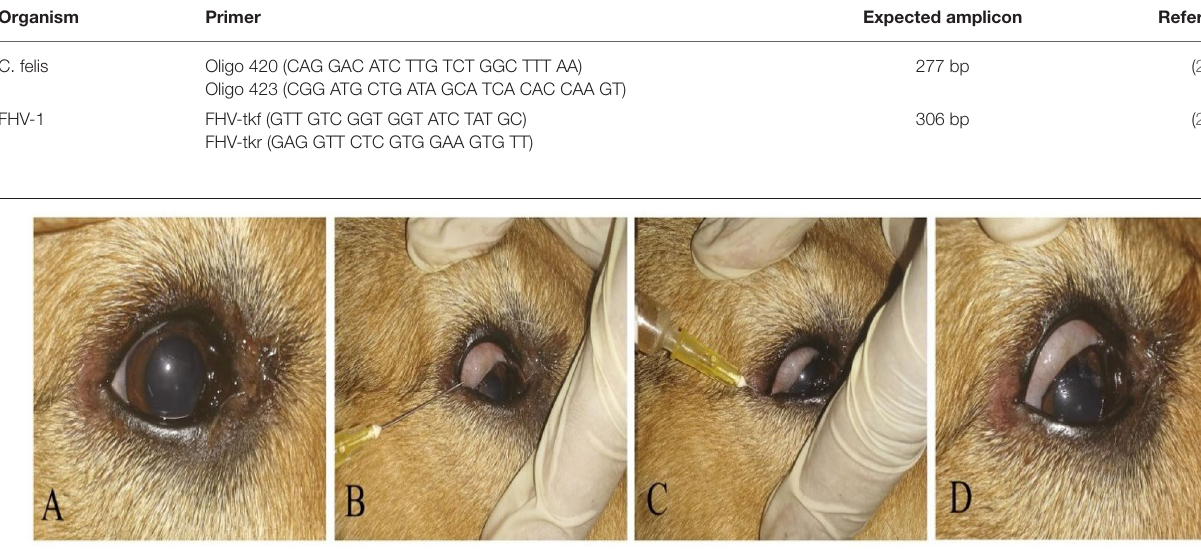
FIGURE 2 | A photography series showing the technique of PRP conjunctival injection in the upper and lower eyelids and conjunctival pouch. (A) Before injection, (B,C) PRP injections in upper and lower eyelids and conjunctival pouch, (D) eye after injection.